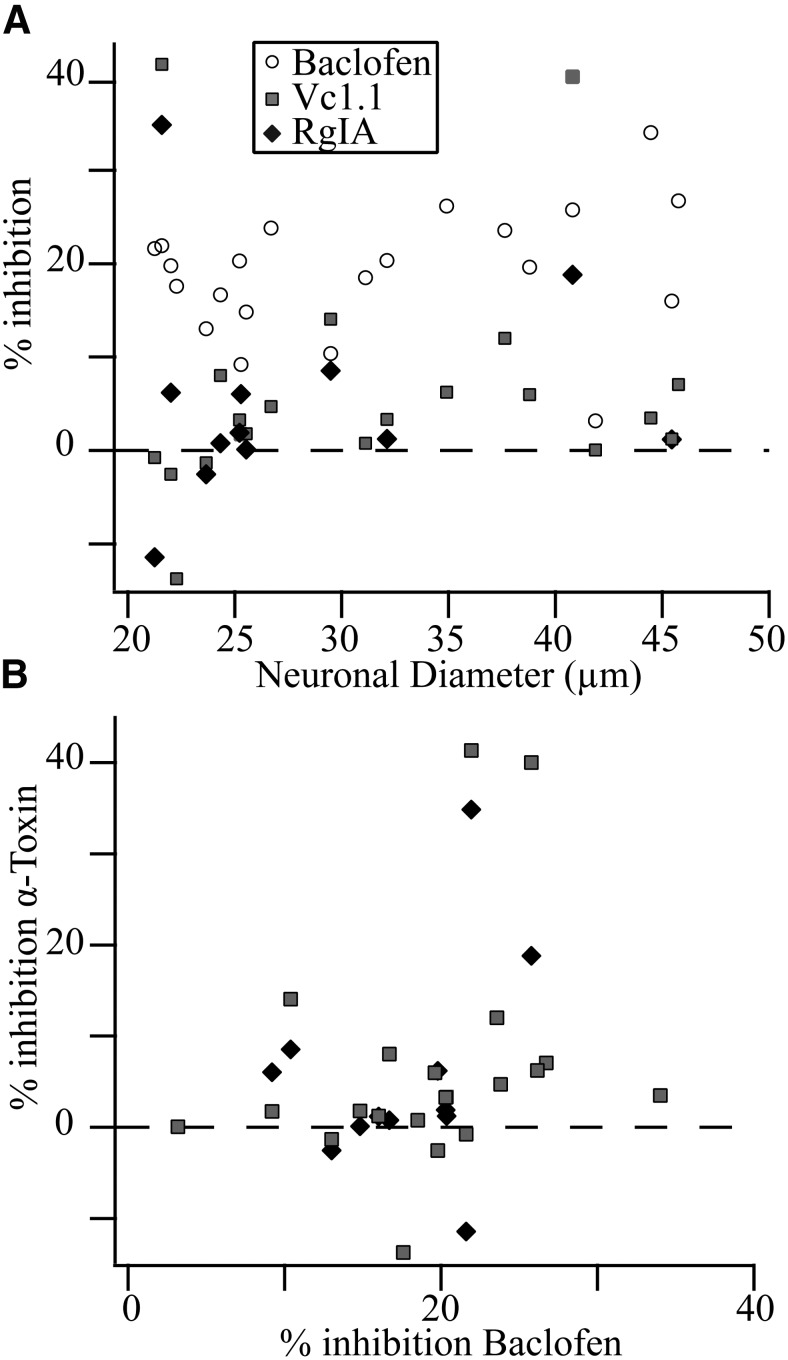
Inhibition by α-conopeptides Vc1.1 or RgIA does not correlate with inhibition by the GABAB agonist baclofen. A, The percent inhibition of prepulse CaV current by 30 µM baclofen, 1 µM Vc1.1, or 1 µM RgIA is plotted versus cell diameter (calculated as described in Materials and Methods). B, The percent inhibition of prepulse CaV current by α-conopeptides Vc1.1 or RgIA is plotted versus percent inhibition by baclofen, and no correlation was observed.